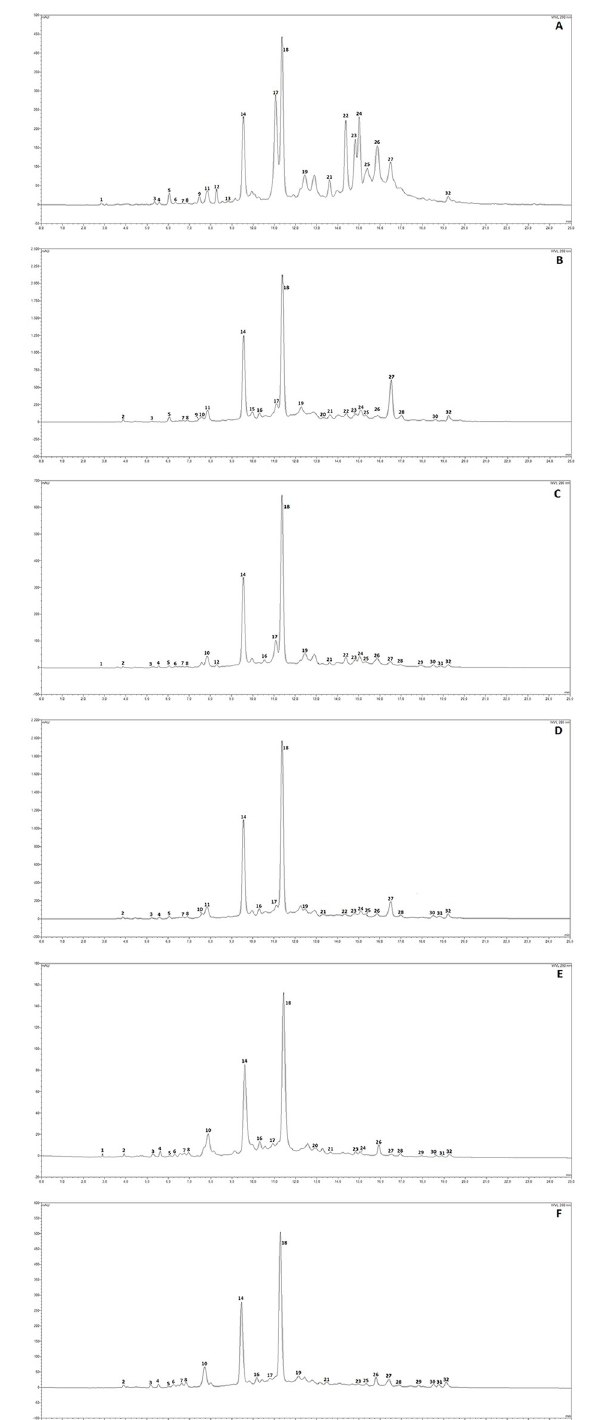
Fig 3. HPLC-DAD chromatograms of pomegranate matrices (at 280 nm). A) Extract from ‘baby red’ immature pomegranate mesocarp and arils (BR-PA). B) Extract from ‘baby red’ immature pomegranate peels (BR-B). C) Extract from ‘baby green’ immature pomegranate mesocarp and arils (BG-PA). D) Extract from ‘baby green’ immature pomegranate peels (BG-B). E) Extract from ripe pomegranate mesocarp and arils (M-PA). F) Extract from ripe pomegranate peels (M-B). See Fig 2 for matrix identification, Table 1 for numbering and Material and Methods for details.